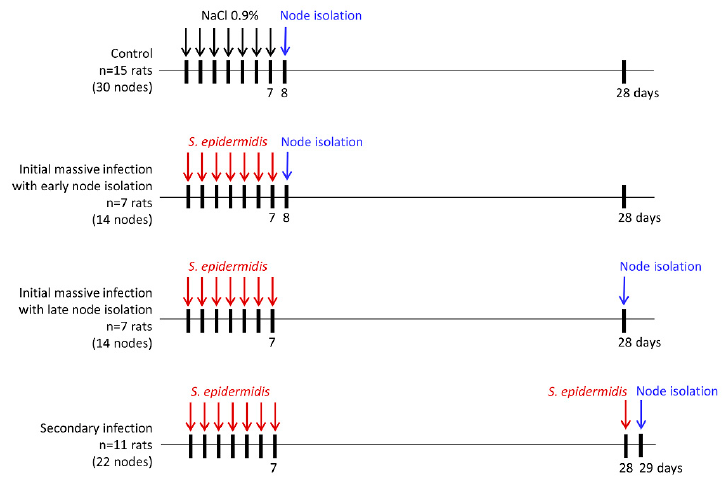
Figure 1. Experimental groups.